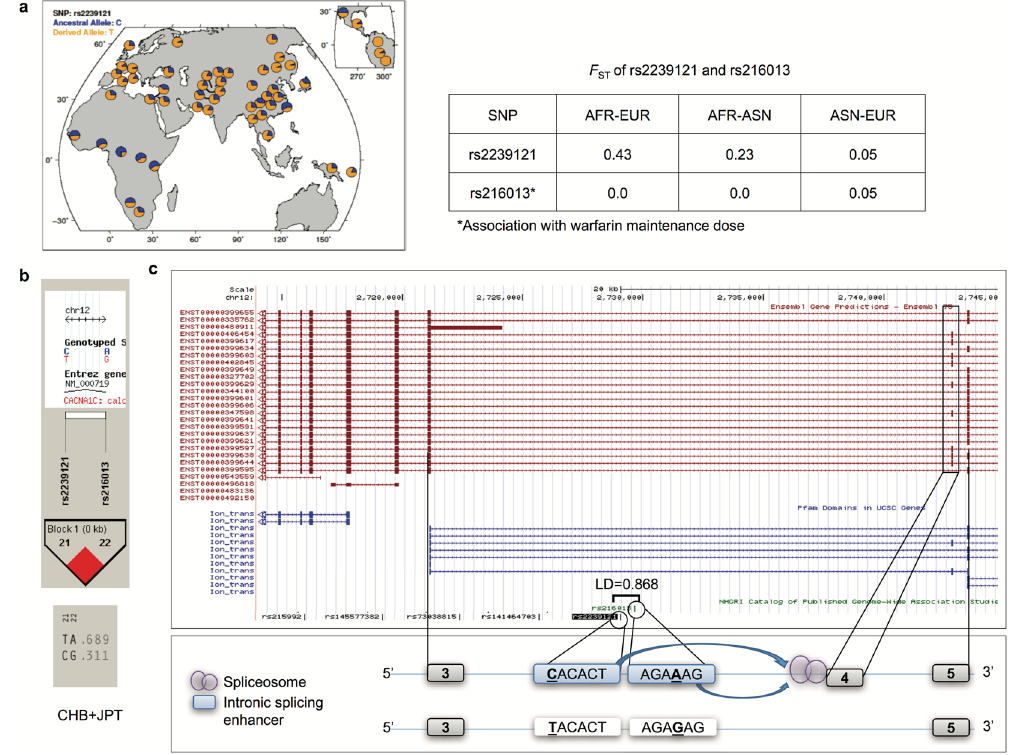
Figure 6. Pharmacogenetic variant rs2239121 in CACNA1C . ( a ) Geographical distribution of allele frequency of the SRE-disrupting allele T. rs2239121 is highly differentiated between the AFR and EUR population,